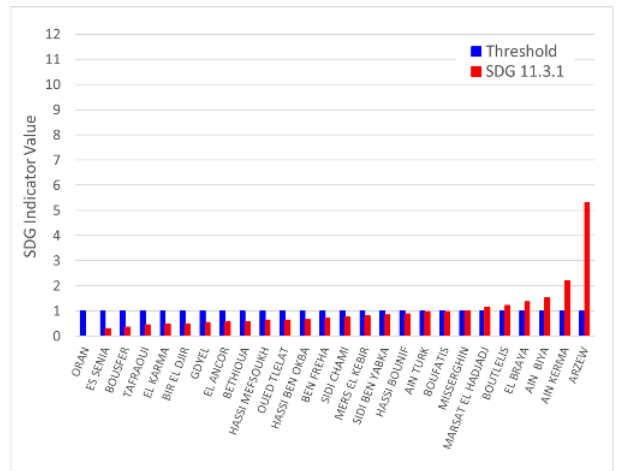
Figure 10. SDG 11.3.1 indicator values for the communes in the Oran wilaya. The constant blue bars represent the value over which the commune develops away from sustainability.